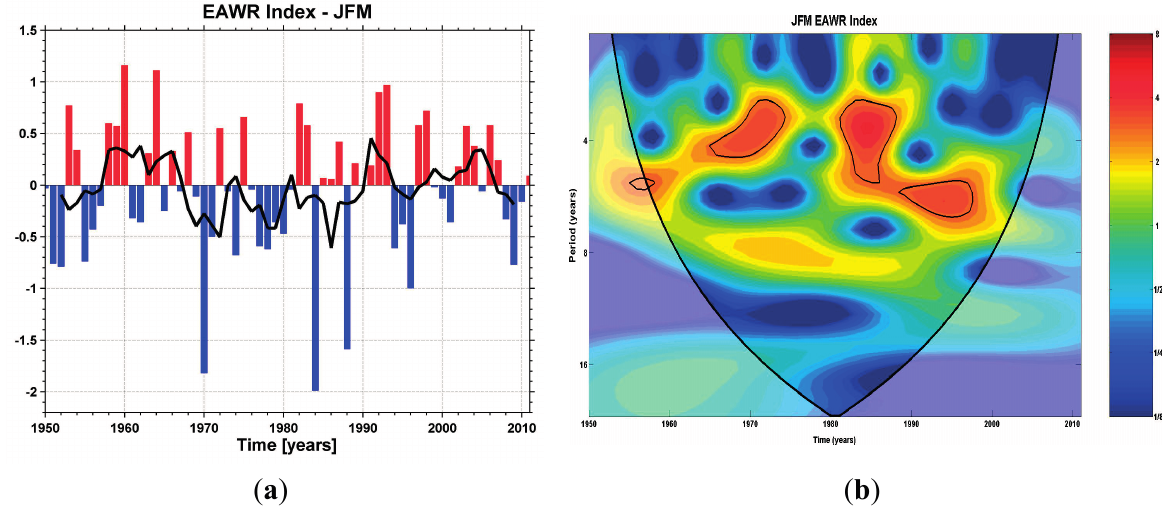
Figure 1. ( a ) Annual January to March (JFM) value of the East Atlantic/Western Russia (EAWR) Index and the 5 years running mean (black line); ( b ) The continuous wavelet power spectrum of the time series of JFM EAWR Index. The thick black line contour is the 5% significance level against red